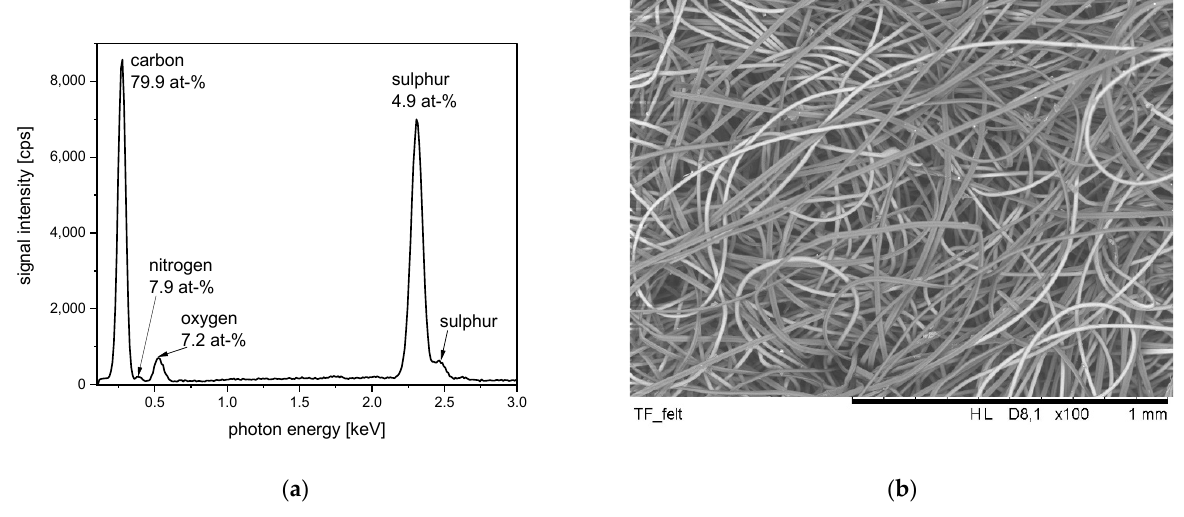
Figure 13. PPS sample from a non-woven filter material with fluoro carbon finish—( a ) EDS spec- trum; ( b ) SEM image.